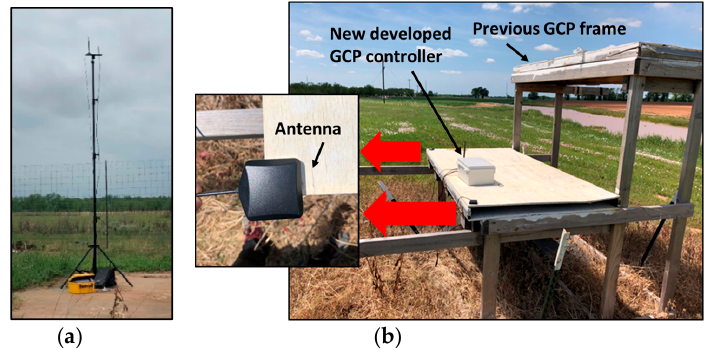
Figure 5. View of ( a ) the base station on the surveyed position and ( b ) the accuracy assessment test in the field.